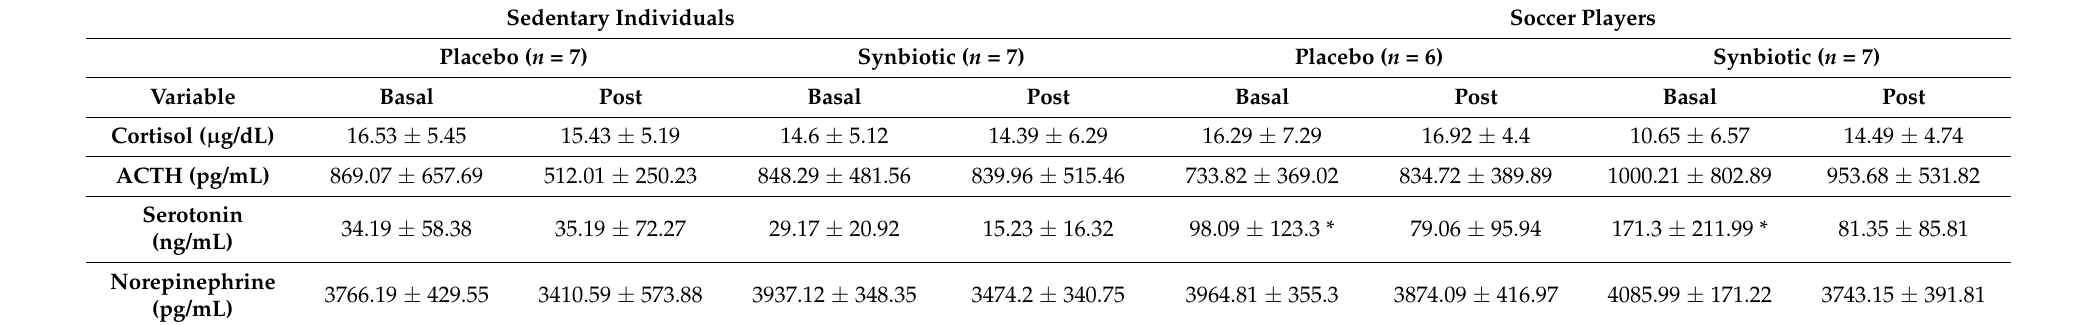
Table 5. Results on immune and stress biomarkers not affected by the